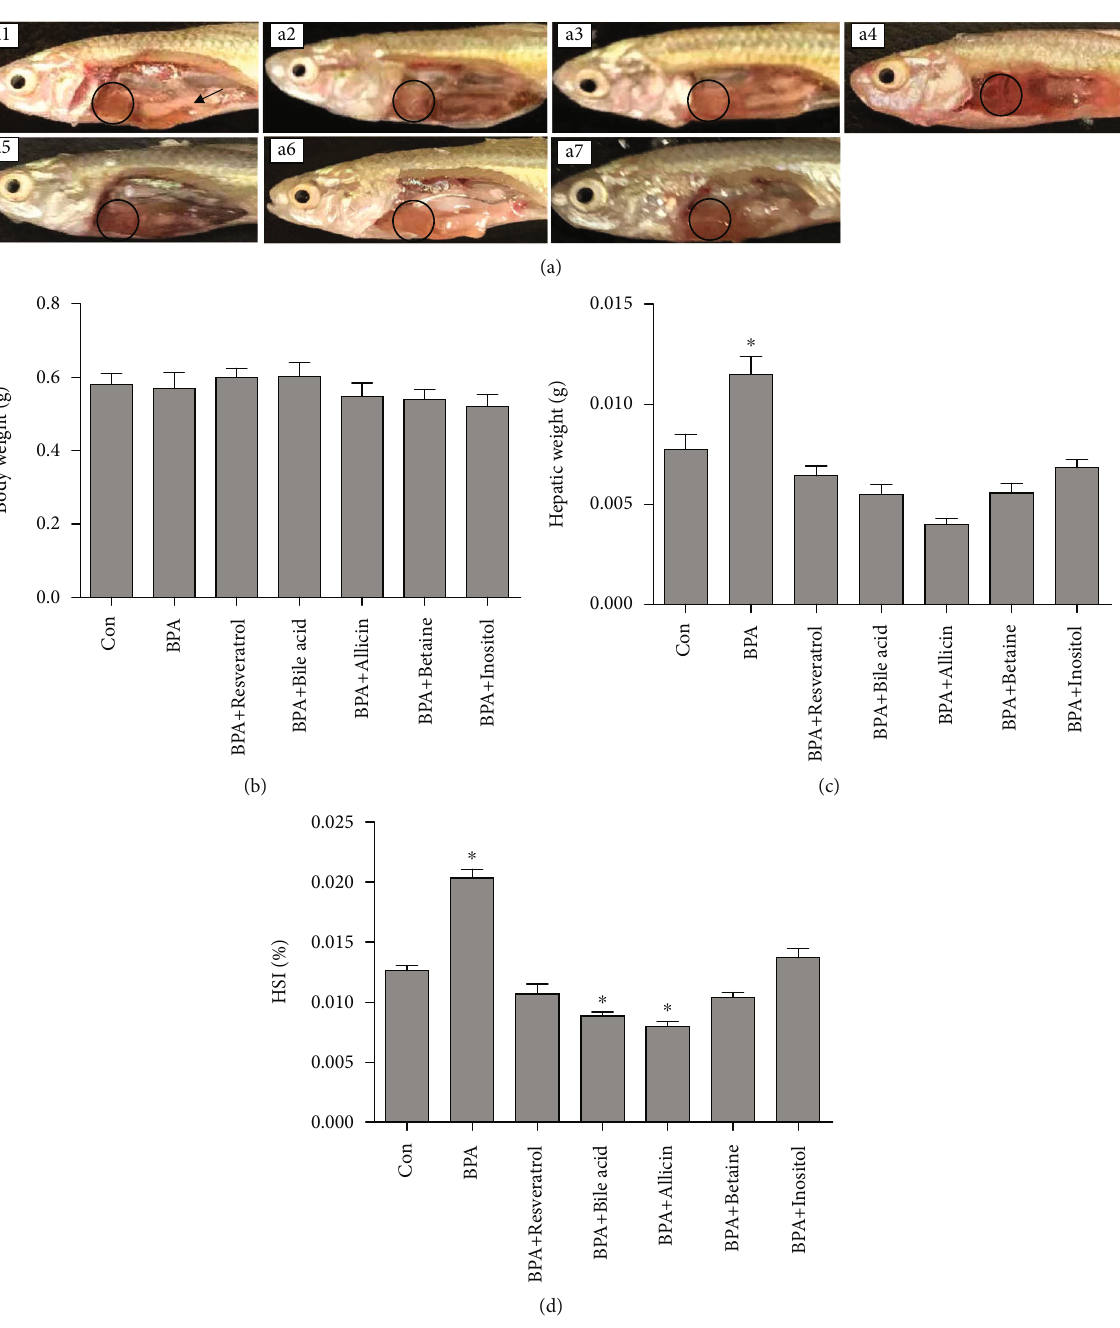
Figure 1: E ff ect of the experimental additives on rare minnow hepatic morphology, body weight, hepatic weight, and HSI. (a) Hepatic morphology, a1: Con, a2: BPA, a3: resveratrol, a4: bile acid, a5: allicin, a6: betaine; a7: inositol; (b) body weight; (c) hepatic weight; (d) HSI. The circle shows part of the liver, and the arrow points to the testis. All statistical data were expressed as mean ± SD ( n =3). ∗ stands for there is a signi fi cant di ff erence between the treatment groups and Con groups ( P < 0 : 05